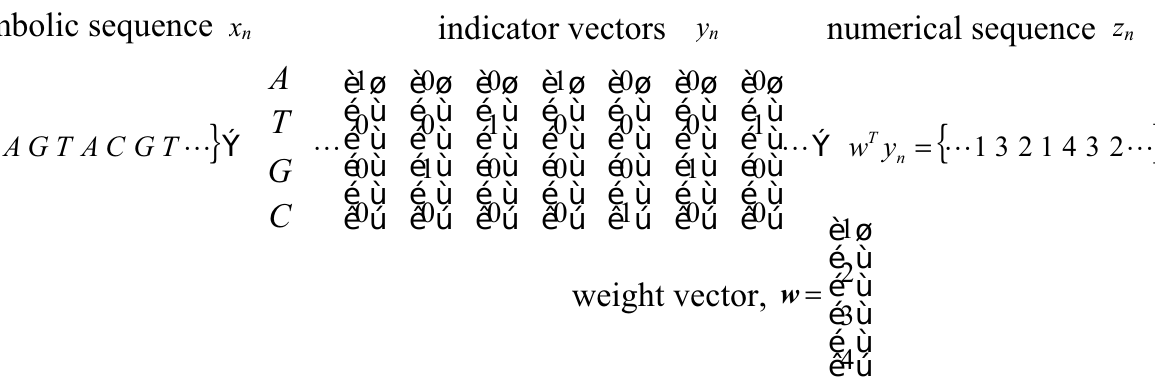
Figure 1 Mapping process from symbolic sequence x n to numerical sequence z n . The indicator vector y n represents the occurrence of the DNA base at index n . From top to bottom, four rows in the indicator vector represent the four DNA bases A, T, G and C, respectively. Therefore, a DNA sequence can be separated into four channels of sequences. Weight vector is used to map the indicator vectors to a numerical sequence by the inner product operation. Here, the weight vector is exemplified by w =[1,2,3,4] T (Wang and Johnson